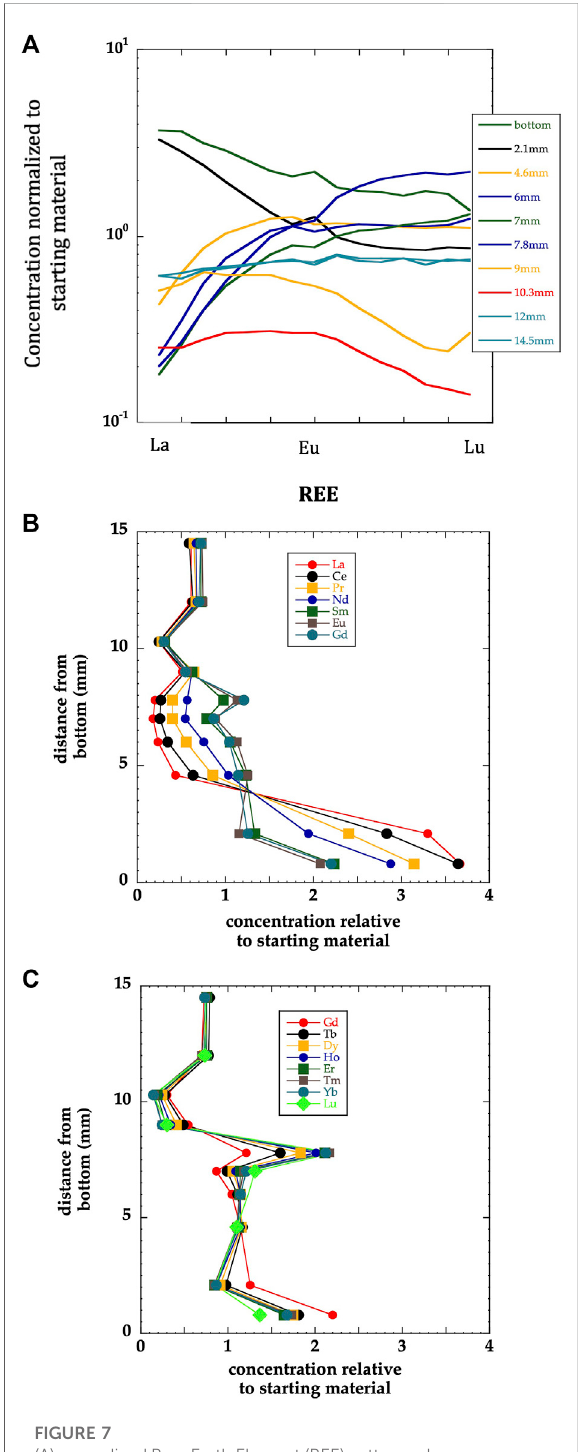
FIGURE 7 (A) normalized Rare Earth Element (REE) patterns change as a function of position, re fl ecting how REE partition between melt andthemineralassemblageateachtemperature.Forinstance,the 7.8 mm pattern shows HREE enrichment due to garnet ’ s presence, while the two bottom subsamples atthe cold end of the experiment show LREE enriched patterns due to the presence of apatite and carbonates. The patterns are de fi ned by analyses